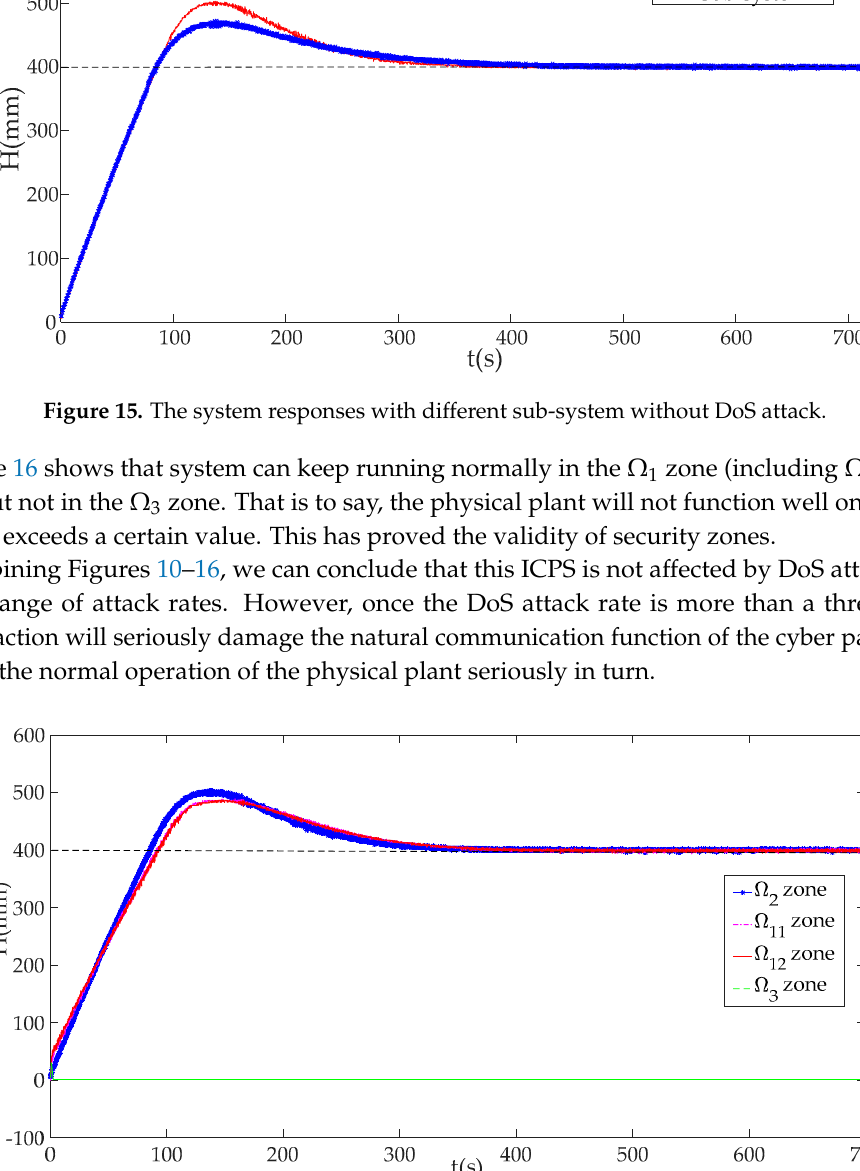
3 Ω Figure 14. Average transmission time delay under different DoS attack rates. The above table and charts show that the normal running of ICPS will not be affected by malicious attacks when the attack rate is less than a certain value. Usually, if the ICPS is not attacked by a DoS attack or the ICPS is under the DoS attack with an attack rate lower than fr 2 , the time delay must be in the range Min TD to Max TD. Due to the performance limitations of network devices, the time delay can’t be less than Min TD. Once the time delay exceeds Max TD, the performance of the ICPS will be destroyed. The randomness of time delay makes us select Average TD as an indicator to show the network performance. That is to say, we don’t have to consider DoS attacks when the ICPS is running in the 1 Ω zone, which also demonstrates the correctness of Section 2.4. 5.2. Mimicry Security Strategy In this subsection, we analyze the effect on an ICPS’s physical part against DoS attack with